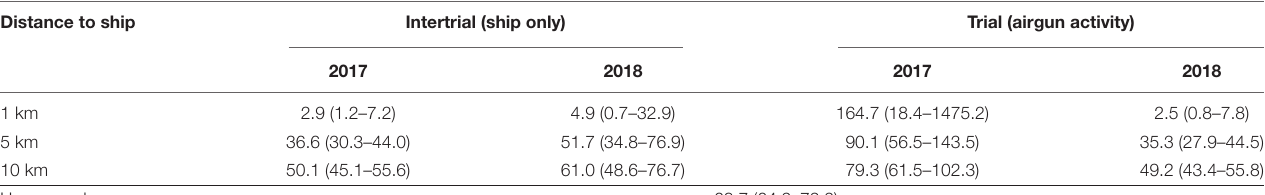
TABLE 4 | Sojorn time, i.e., the average time (in min, with 95% confidence limits) that whales stayed far from the coast (in the Far state) before changing to any of the other two states, for normal unexposed behavior (bottom line) and for given distances to the ship under the four exposure levels. Distance to ship Intertrial (ship